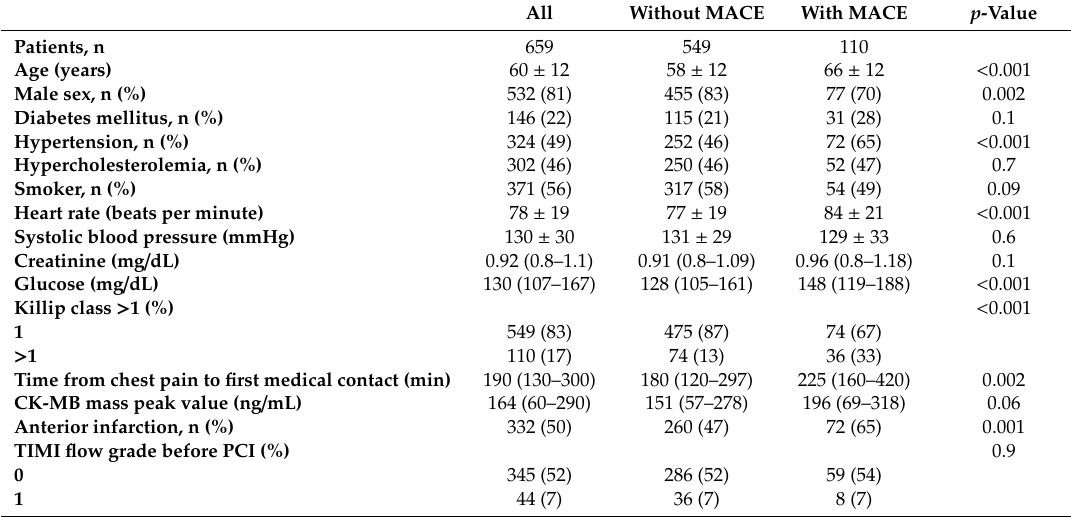
Table 1. Baseline characteristics of STEMI patients with and without MACE. All p